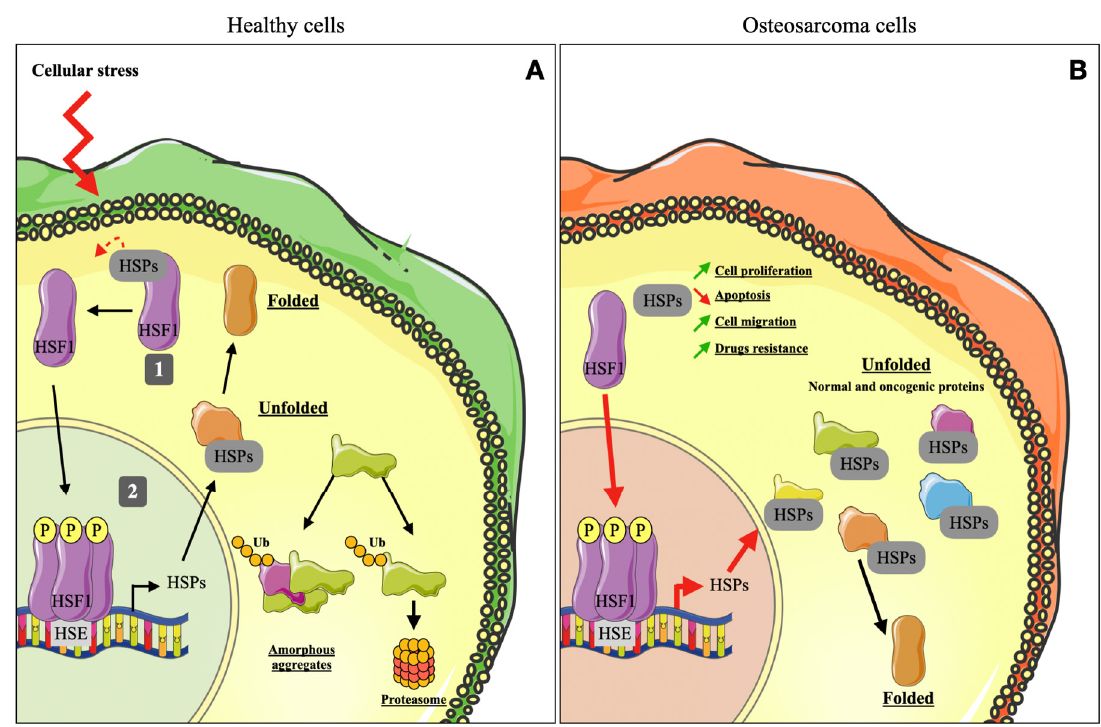
Figure 1. HSR and HSP functions in a healthy cell and OS cell. ( A ) Under physiological conditions, HSF1 is complexed with HSPs and is located in the cell cytoplasm (1). During cellular stress, HSF1 is phosphorylated, trimerized and translocated into the nucleus where it binds to the HSE motif and initiates transcription of HSPs (2). Some unfolded proteins are taken over by HSPs to be refolded. Others are ubiquitinylated and degraded by the proteasome. Accumulation of unfolded proteins leads to amorphous aggregations, compromising the cell’s survival. ( B ) In a cancer cell, HSF1 is over-activated and initiates the transcription of numerous HSPs, which take over normal and oncogenic unfolded proteins and refold them, thereby averting proteomic instability. Furthermore, HSPs are directly involved in different mechanisms that promote cell survival, such as cell proliferation and migration, apoptosis and drug resistance. HSE: Heat Shock Element; HSF1: Heat Shock Factor 1; HSPs: Heat Shock Proteins; Ub: Ubiquitin; P: